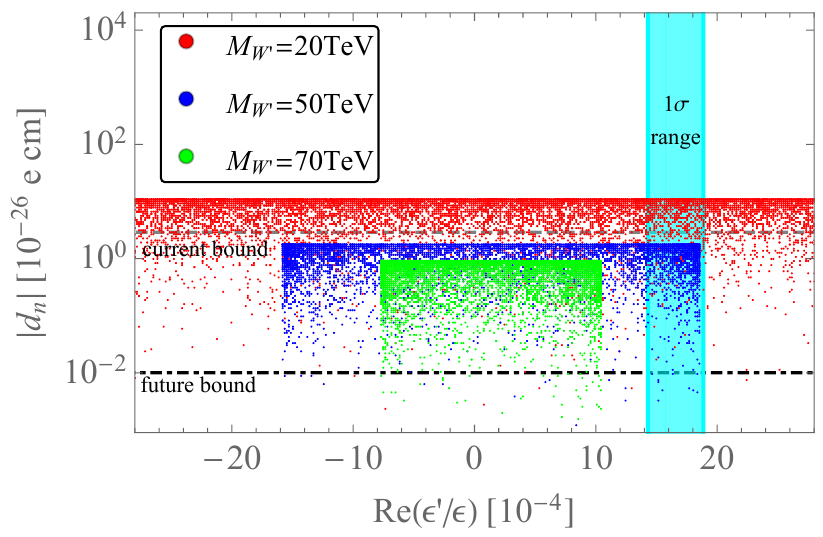
Figure 5 . Correlation plot for the direct CP violation in K ! (cid:25)(cid:25) decay and the neutron EDM in the case with (cid:22) (cid:18) = 0 without Peccei-Quinn mechanism. A gray dashed line and a black dashed dotted line represent the current [69] and the future [71] bounds on the neutron EDM, while a cyan band stands for the 1 (cid:27) range of the direct CP violation in K ! (cid:25)(cid:25) decay obtained from PDG [8].